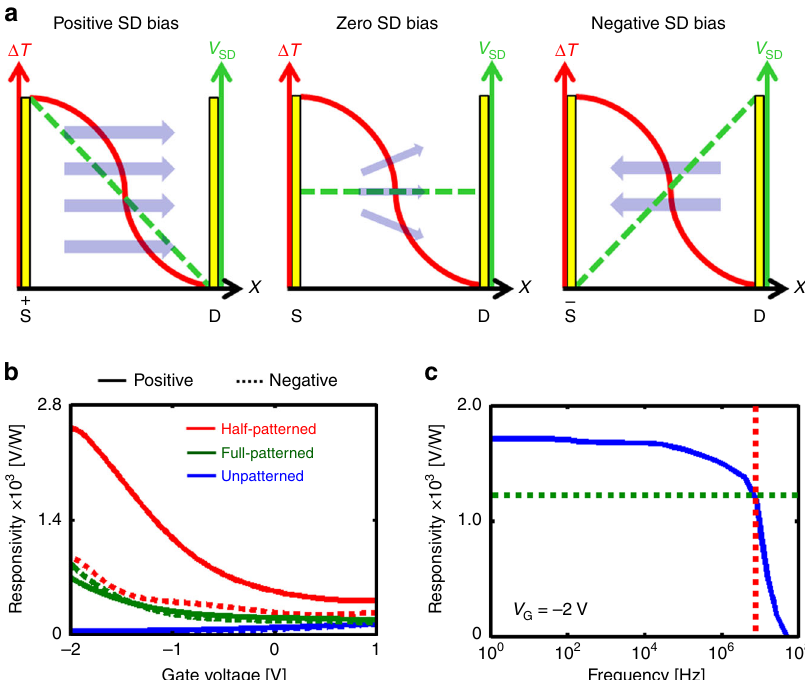
Fig. 3 A.C photoresponse results. a Schematic showing the A.C photocurrent for different measurement conditions. b A.C responsivity of the half- patterned (red), full-patterned (green) and unpatterned (blue) graphene detectors for the positive (solid) and negative (dashed) offsets (0.25 V) at f = 20 Hz. c A.C responsivity as a function of frequency for V = − 2V. The crosshair shown in dashed lines corresponds to the cut-off G